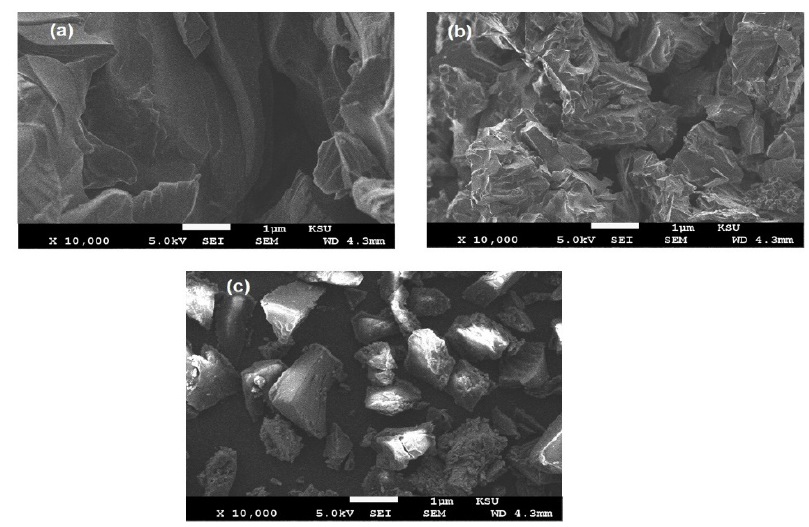
Figure 4. SEM micrographs of ( a ) HCh, ( b ) HCh-TH2, and ( c ) MCh-TH2.